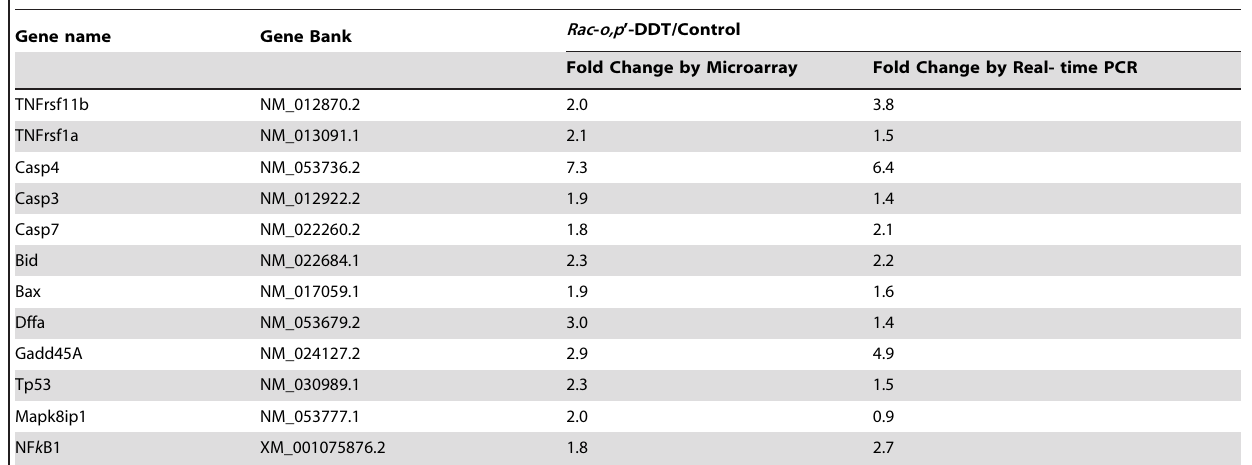
Table 1. Results of RT-PCR verification of microarray on rac-o,p ’-DDT.